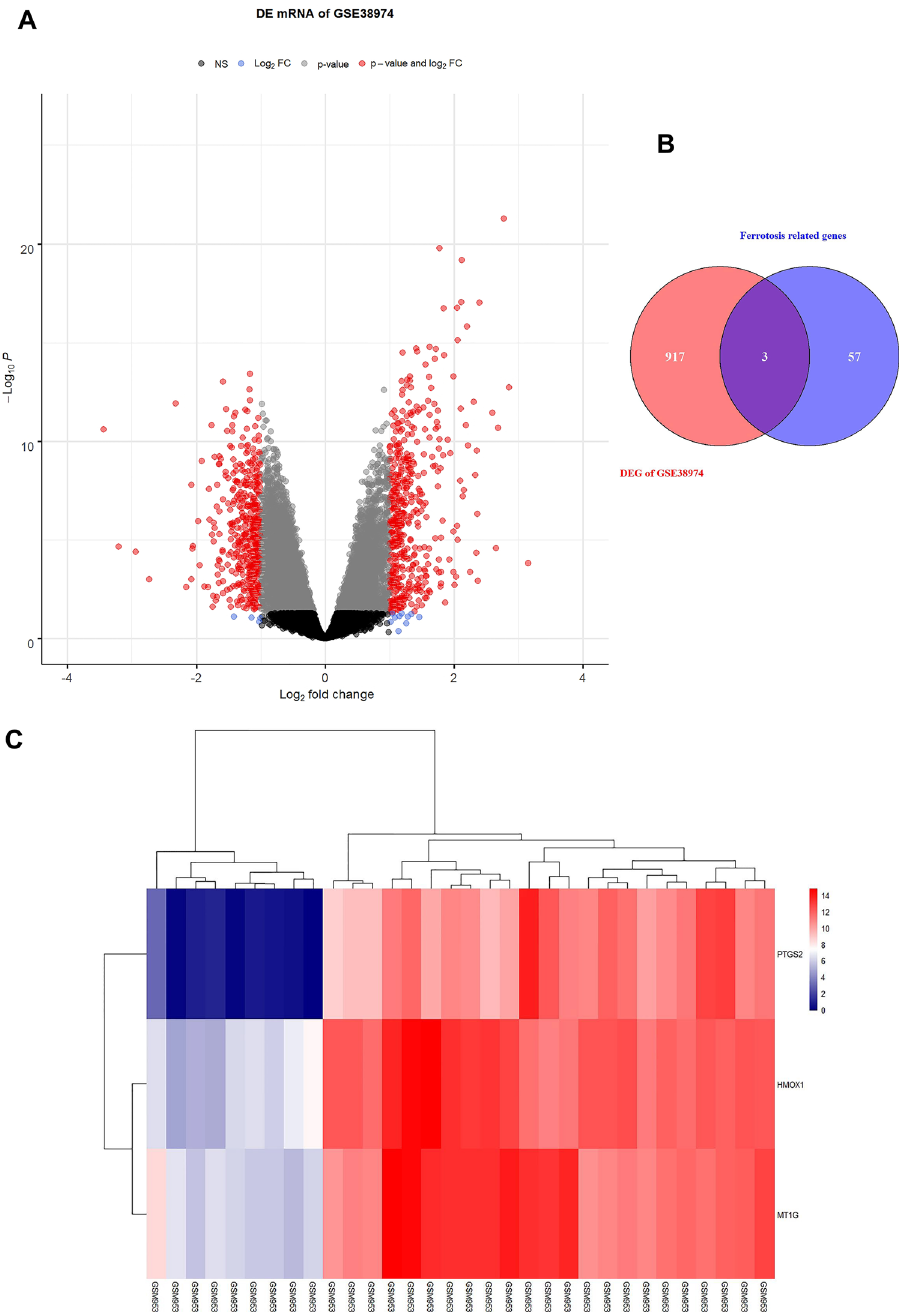
Figure 5. PTGS2/PGE2 signaling pathway affected CSE-induced ferroptosis in BECs. ( A ) Screening of DEGs. Red dots are differentially expressed mRNAs, and blue dots are stable genes. ( B ) Venn diagrams of DEGs and ferroptosis-related genes. ( C ) The cluster heatmap visualization of ferroptosis-related differential genes (drawn with R language). ( D ) qRT-PCR verification of PTGS2, HMOX1, and MT1G expression. ( E ) PTGS2 expression was determined by qRT-PCR and western blot. ( F ) ELISA detection of PGE2, and lipid peroxidation MDA and SOD. ( G ) The content of catalytic Fe (II) was detected by FCM. ( H ) The protein expression of ferroptosis markers TfR, FtL, and GPX4. *P < 0.05 vs. Control, #P < 0.05 vs. CSE, &P < 0.05 vs. CSE + NC. The data were presented in the form of mean ± standard deviation. n =